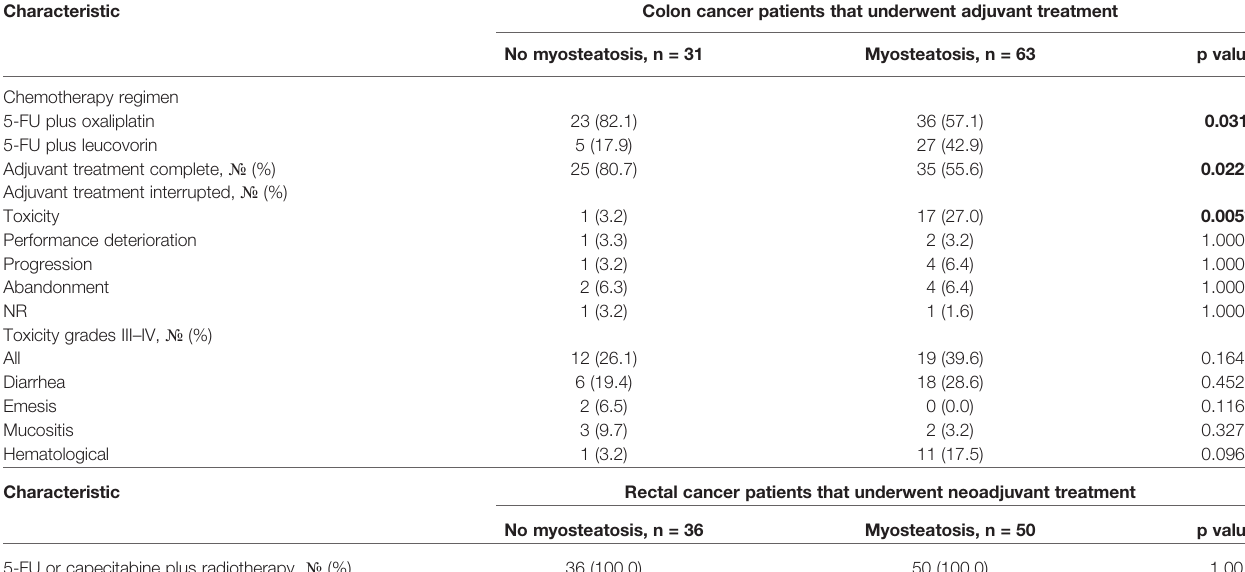
TABLE 4 | Selected adjuvant and neoadjuvant treatment characteristics according to myosteatosis of stage I – III colon and rectal cancer patients, respectively. Characteristic Colon cancer patients that underwent adjuvant